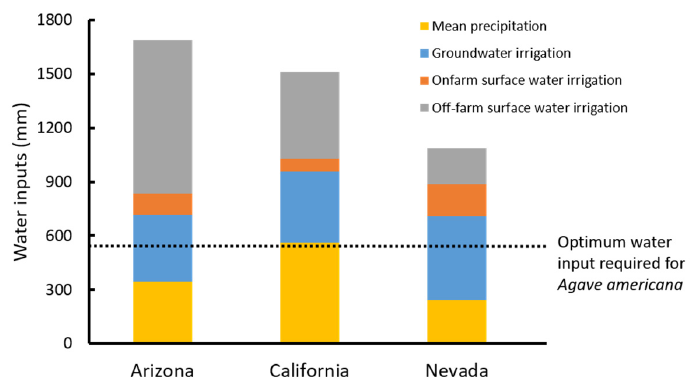
Figure 5. Water inputs from agricultural crops in three southwestern states. Mean precipitation (yellow) reflects the 30-year average [30]. Irrigation from groundwater (blue), onfarm surface water (orange), and off-farm surface water (gray) are distinguished (source: [29]). The dotted line indicates the water requirement required for water to be non-limiting for the growth of Agave americana.